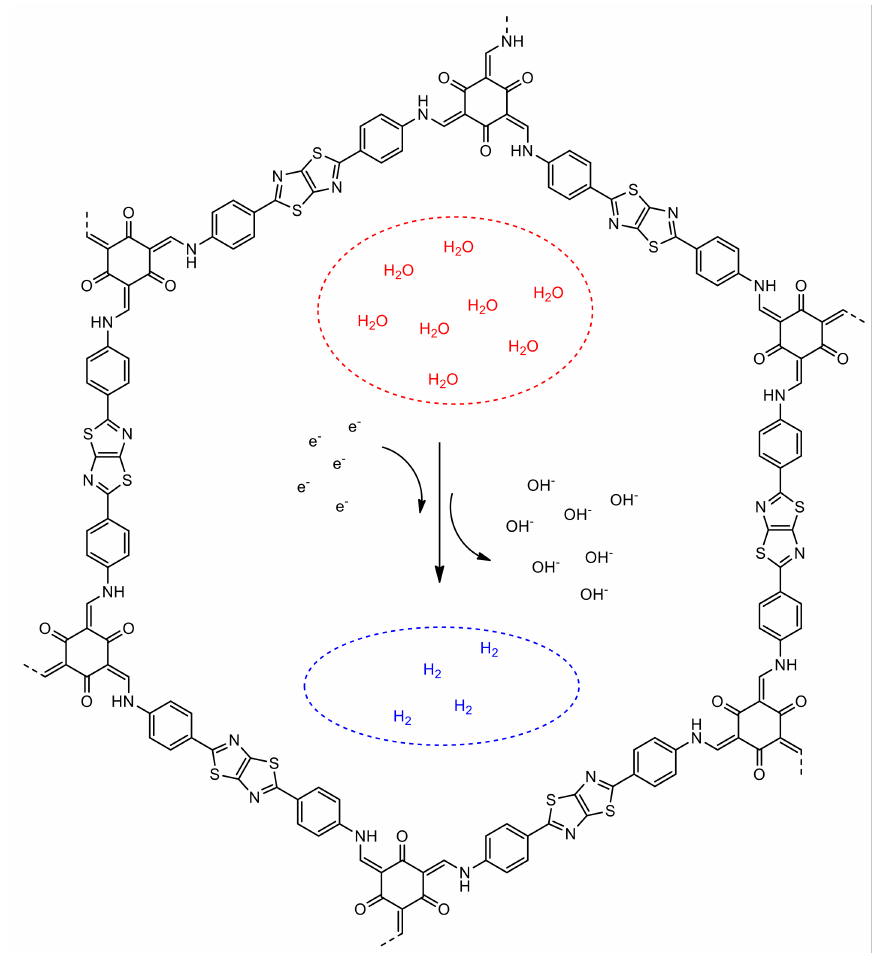
Figure 17. Structure of TpDTz COF and schematic representation of photocatalytic H 2 evolution